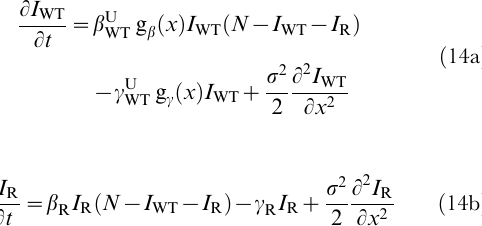
Figure S1 Reciprocal Invasion Plot. It is the same plot as in figure 2 in the main text, but with different axes. Parameters: N= 100, b WTU =0.06, b R = 0.055, b WTT =0.05, c WTU = 1, c R =1.25, c WTT = 1.5 Found at: doi:10.1371/journal.pcbi.1000337.s002 (0.20 MB TIF) Figure S2 Reciprocal Invasion Plot. The parameters are different than in figure S1, and a fourth outcome is possible in zone (4). It corresponds to a situation where, at equilibrium, only one strain is maintained, but its type depends on the initial